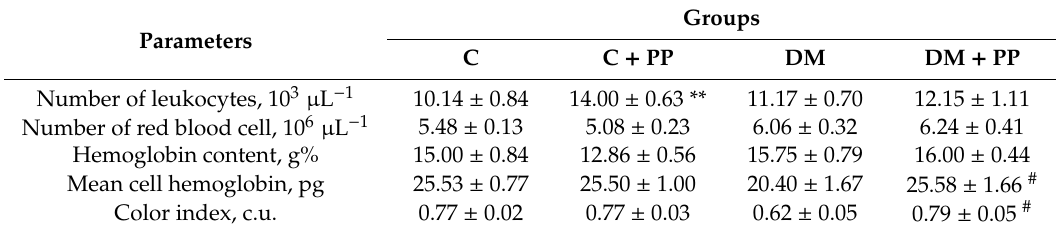
Table 2. The e ff ect of Blue Congo extract on the number of leukocytes and red blood cells, and hemoglobin concentration in rats (cid:48) blood. Designations: ** p < 0.01 compared to the control group; # p < 0.05 compared to the DM group; C—control; PP—treated with purple potato extract; DM—diabetes